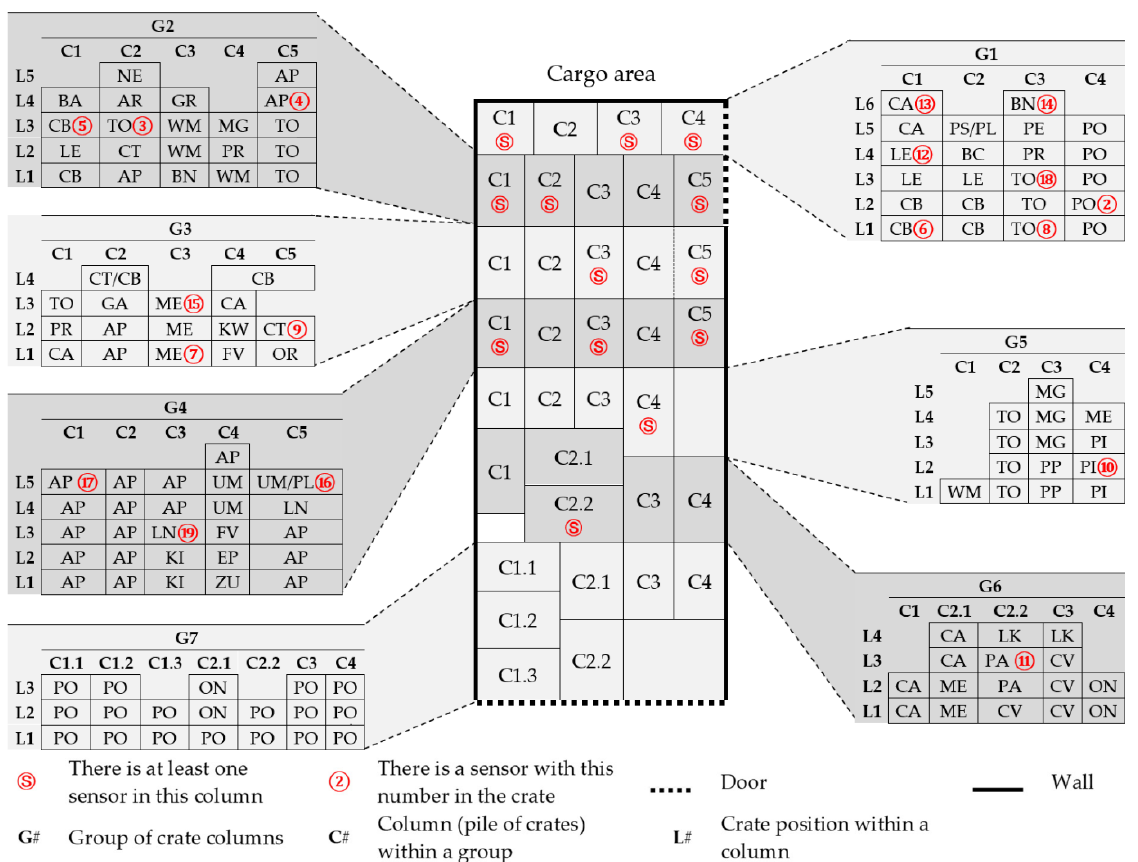
Figure 7. Organization of crates among the cargo area and sensor distribution.